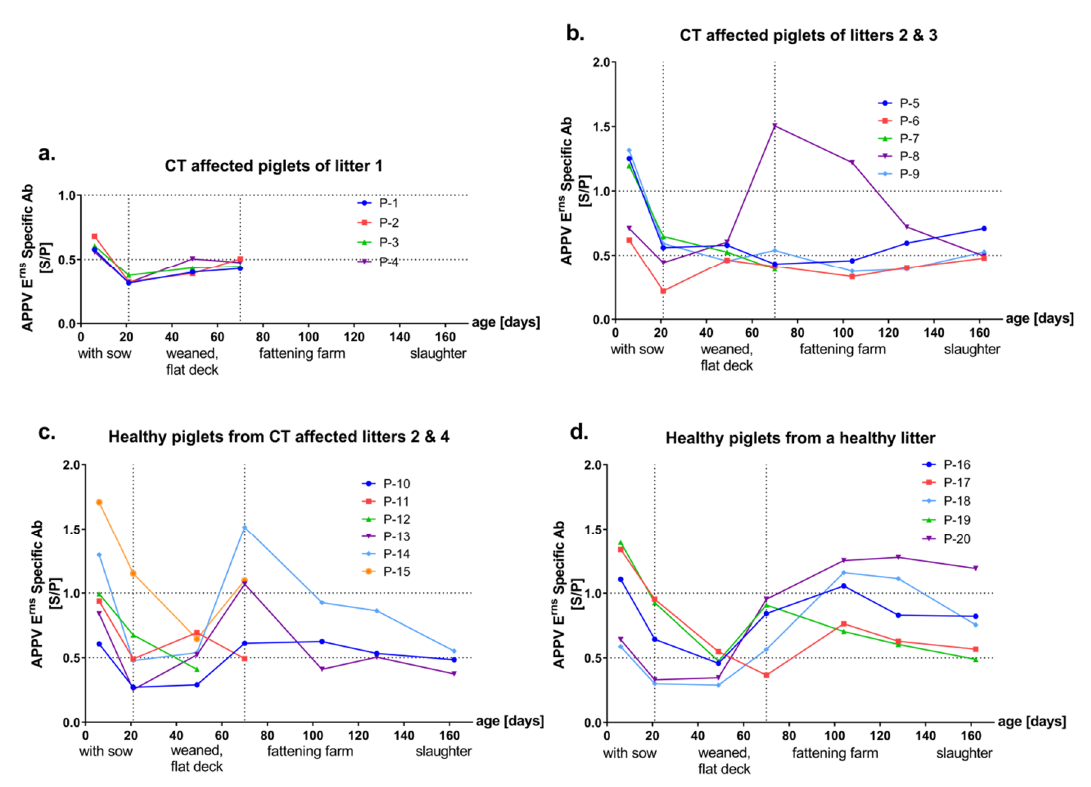
Figure 3. Kinetics of E rns -specific antibodies induced after APPV infection. APPV E rns -specific antibody levels of 20 pigs were investigated by E rns ELISA and results are given as S / P values (S / P ≤ 0.5, low; S / P = 0.5–1.0 intermediate; S / P ≥ 1.0 high reactivity). Horizontal dashed lines indicate the APPV E rns -specific Ab levels as low, intermediate and high. Vertical dashed lines indicate the changes in the holding conditions. Piglets from CT a ff ected litter 1 ( a ) were cross-fostered immediately after birth to a pluriparous sow with a healthy litter. Piglets from CT affected litters 2, 3 and 4 are grouped into two panels ( b,c ) by the occurrence of CT.